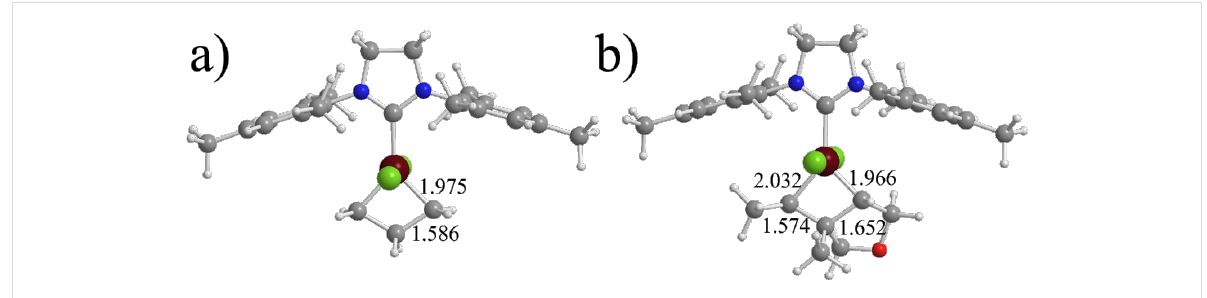
Figure 5: Representative geometries of the metallacycles 7 and 15 , parts a and b, respectively (distance in Å).